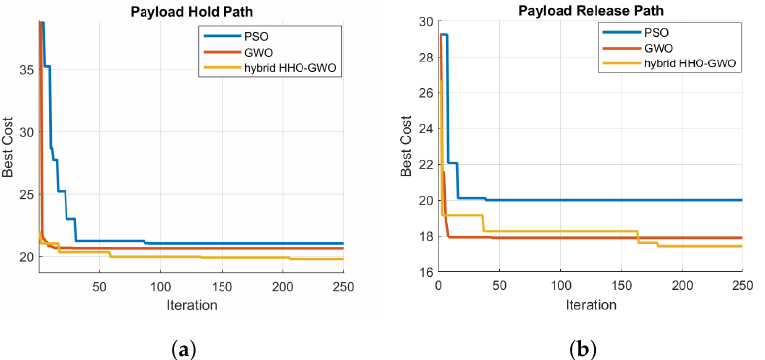
Figure 8. The optimized payload hold ( a ) and release ( b ) path performance of metaheuristic opti- mization algorithms for Map